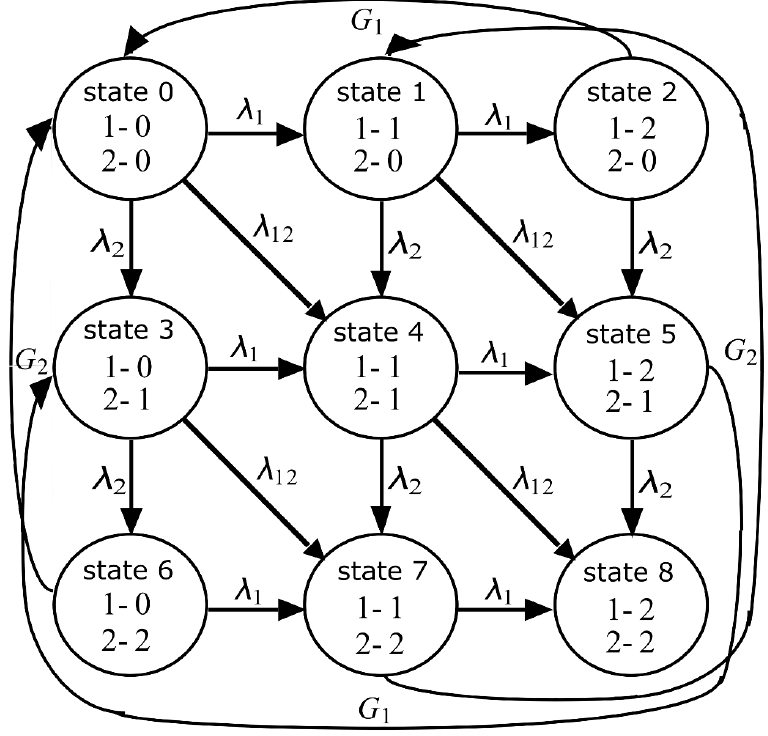
Figure 2. Configuration of the two-unit parallel redundant system with deterioration on 3 × 3